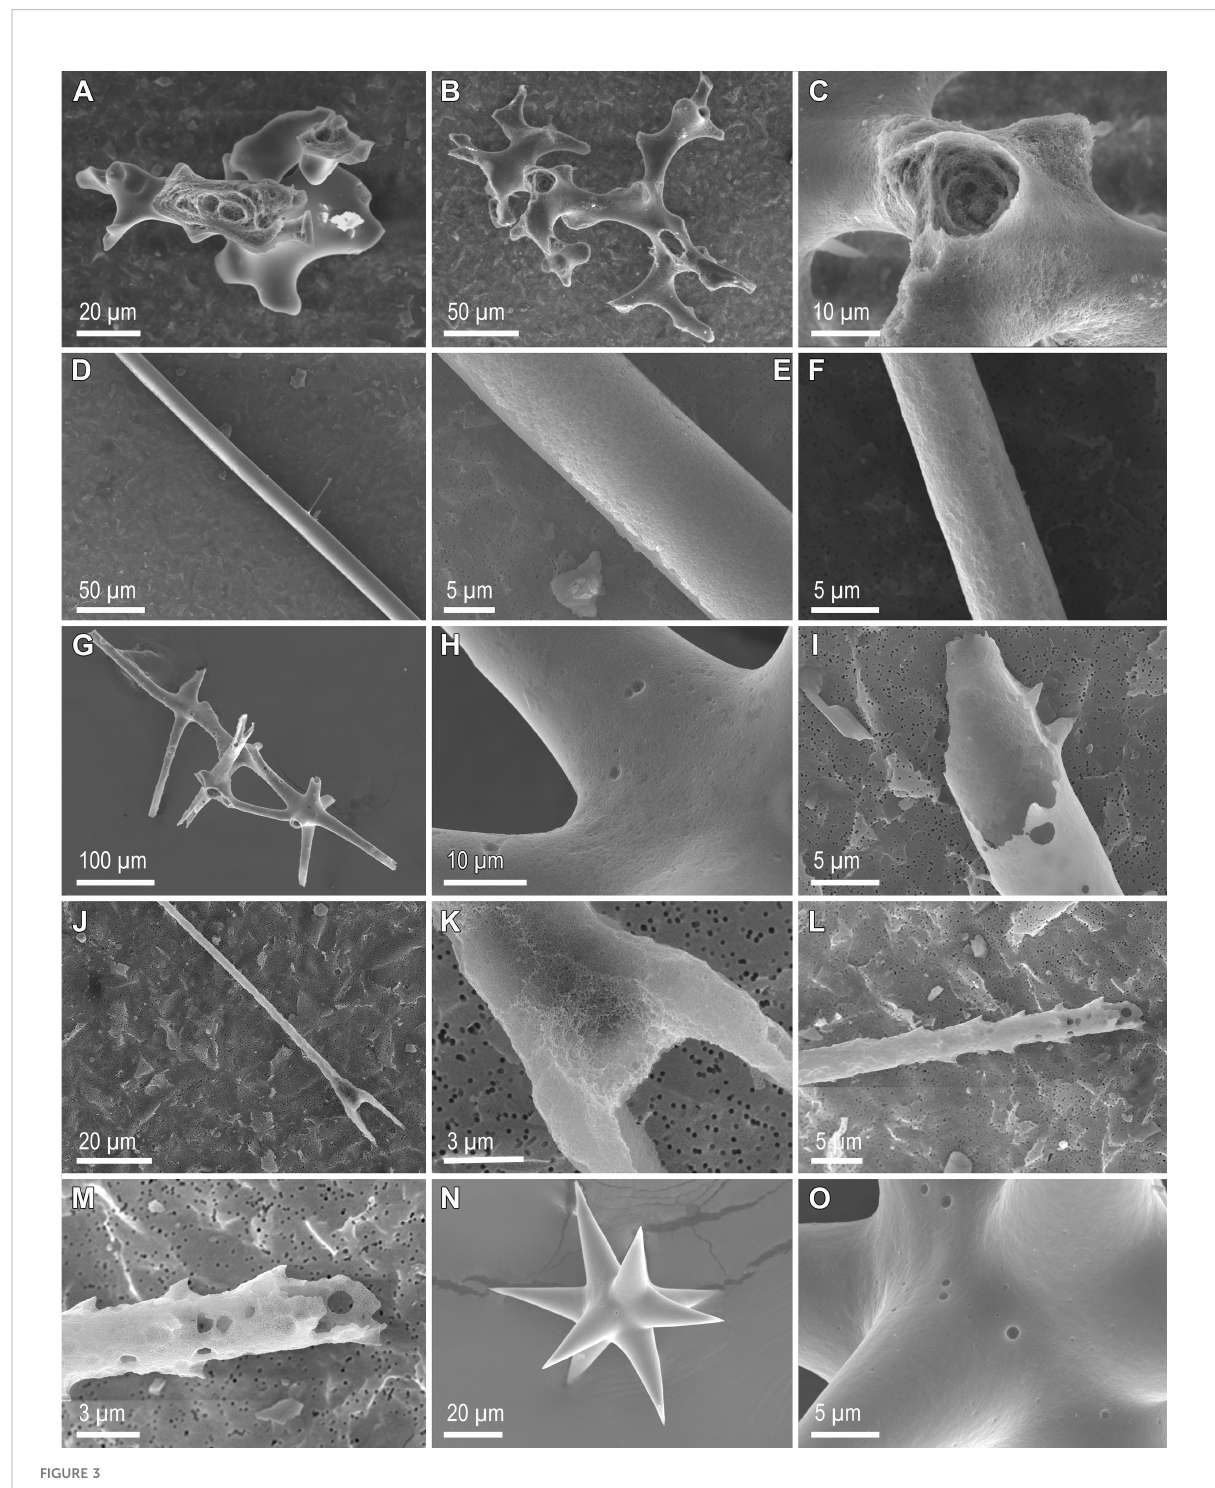
FIGURE 3 Scanning electron microscopy images of sponge skeletal pieces after 6 h and 24 h in 1% sodium carbonate at 85°C. Desmas of demosponge Leiodermatium pfeffeirae have largely resisted dissolution after 6 h (A) and also after 24 h (B) , when only incipient signs of etching at the spicule surface occur (C) . Spicules from the rootlets of demosponge Geodia henstcheli , which remain largely undissolved and with only incipient etching of their silica surface after 6 h (D, E) and 24 h (F) in treatment. Dictyonal framework of hexactinellid Aphrocallistes vastus remaining largely undissolved after 6 h (G, H) , but largely dissolved from the inside after 24 h (I) . In contrast to the framework, some of the isolated spicules from A vastus , such as the scopula (J, K) and the pinnules (L, M) , were largely dissolved at 6 h, but other, such as the small asters (N) , showed only incipient signs of dissolution at this time (O)